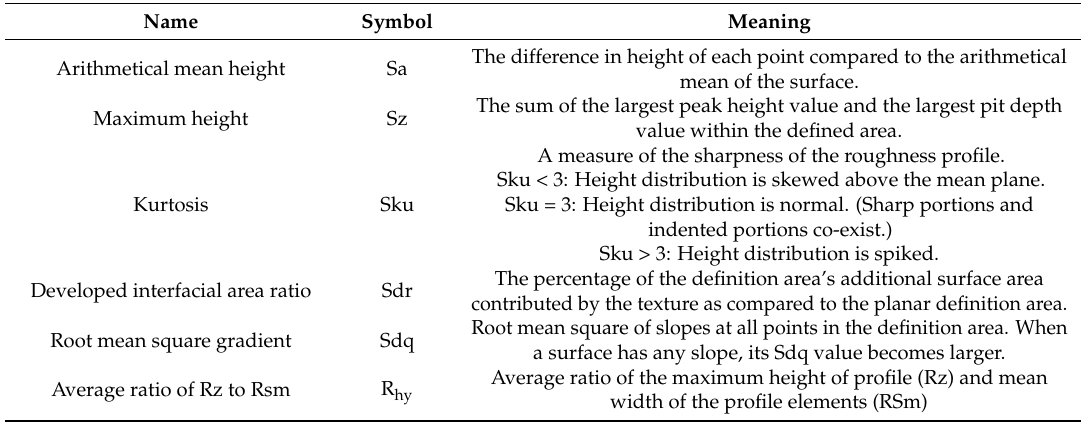
Table 1. Product fingerprint